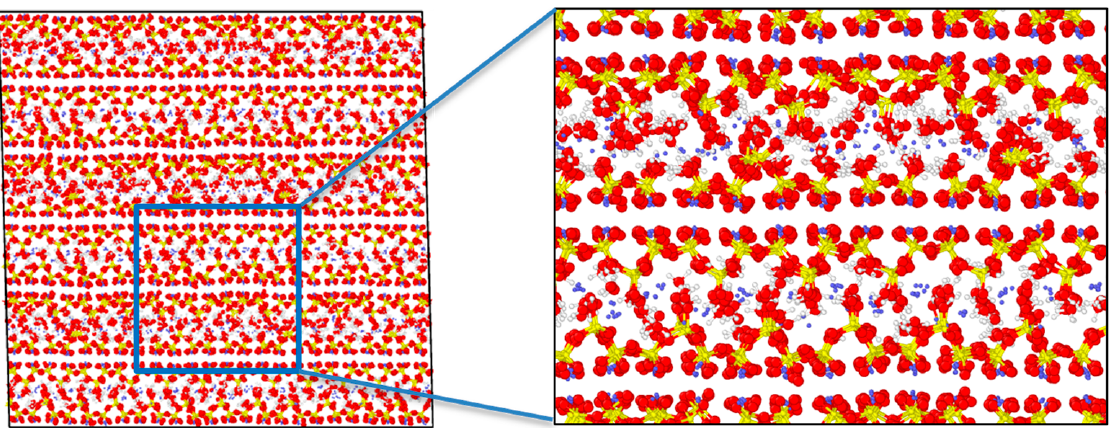
Figure 3. The model of C-S-H for mechanical properties and fracture behavior estimation.